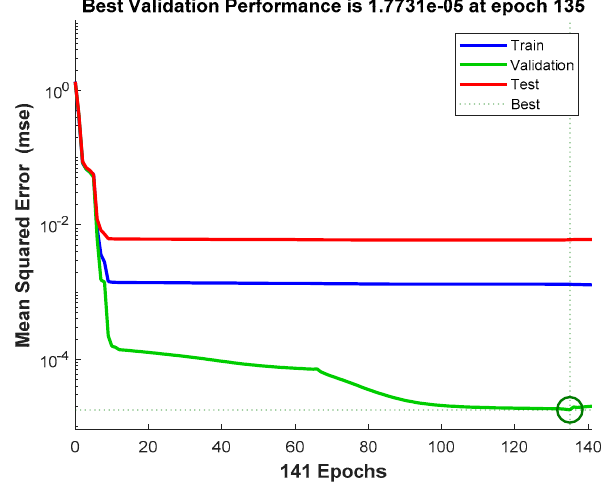
Figure 9. Training trajectory of the developed feed-forward, multi-layer ANN in this experiment, where the training process terminates at the 141-th epoch. Tables 1 and 2 tabulate the load recognition results obtained by the trained feed- forward ANN applied on the training and test datasets, respectively. Tables 3 and 4 show TPR values vs. FPR values for ROC curves obtained by the well-trained and -tested feed- forward ANN applied on the class-imbalanced data set in this